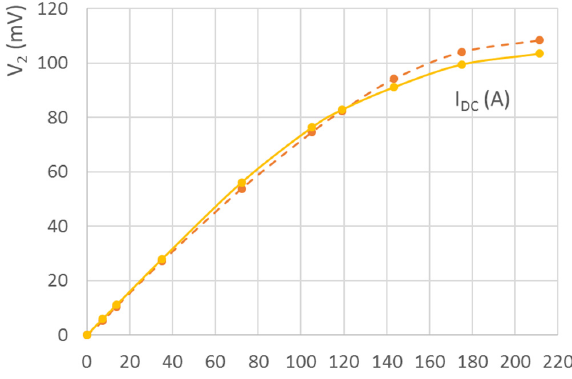
Figure 4. Second harmonic voltage V 2 as a function of the DC current I DC for R 1 = 0 (dashed line) and R 1 = 5 Ω (solid line).